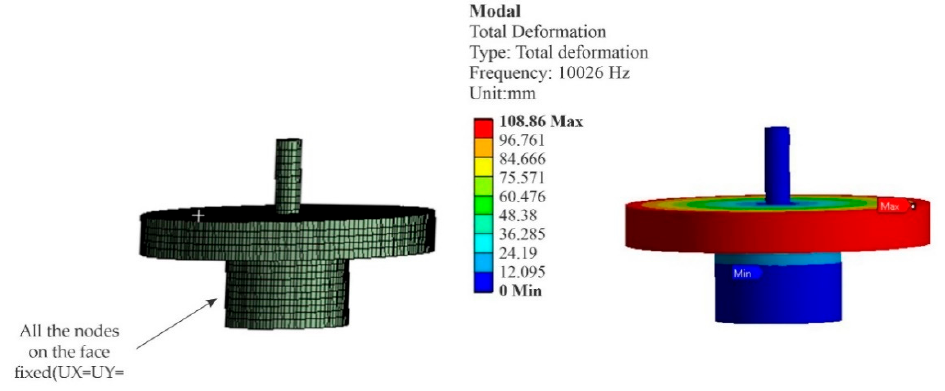
Figure 6. Total deformation of the rotor.